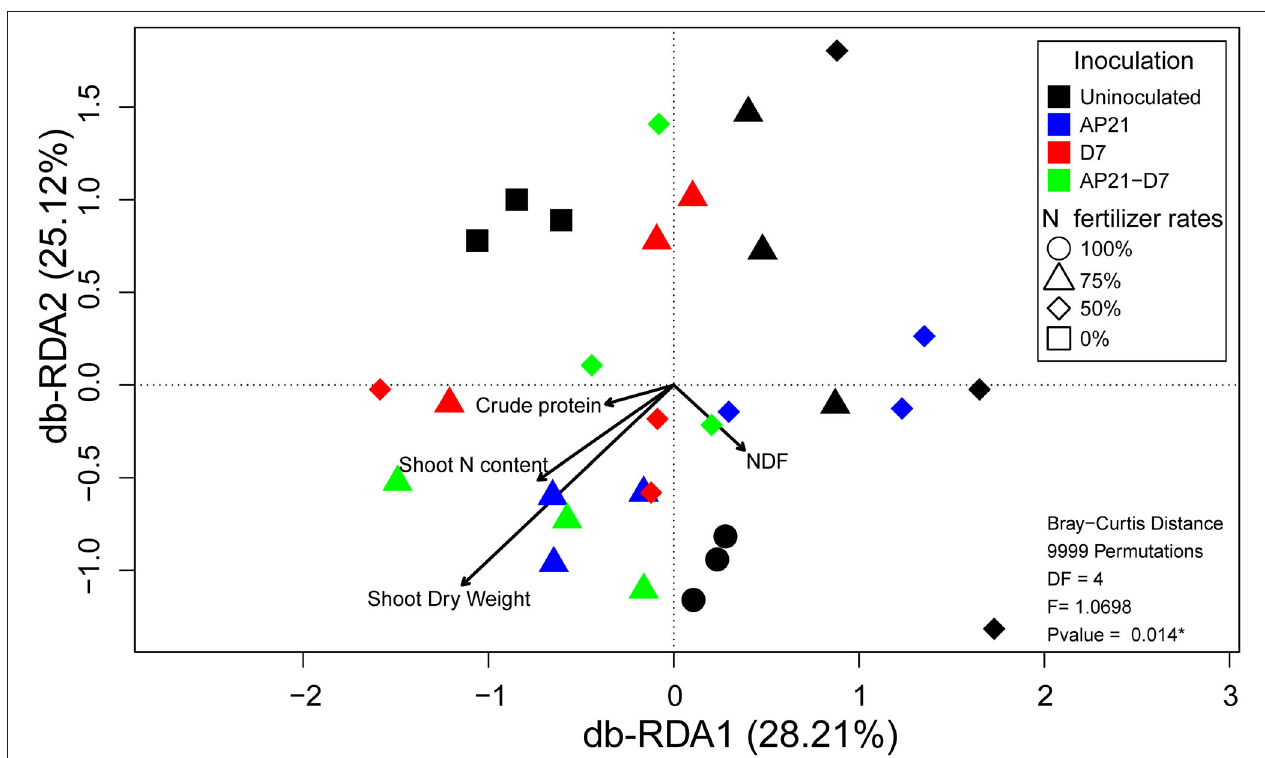
FIGURE 4 | Distance-based redundancy analysis (db-RDA) plot illustrating the bacterial community structure of the rhizosphere in relation to plant parameters. The db-RDA was significant ( p < 0.05).